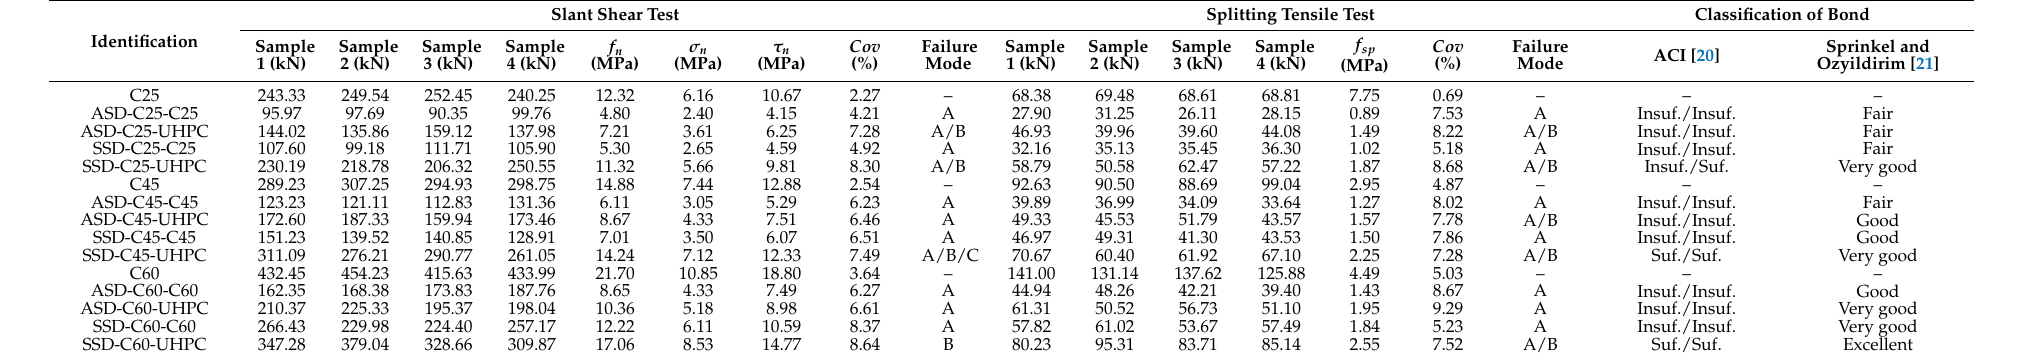
Table 7. Experimental results in the slant shear and splitting tensile